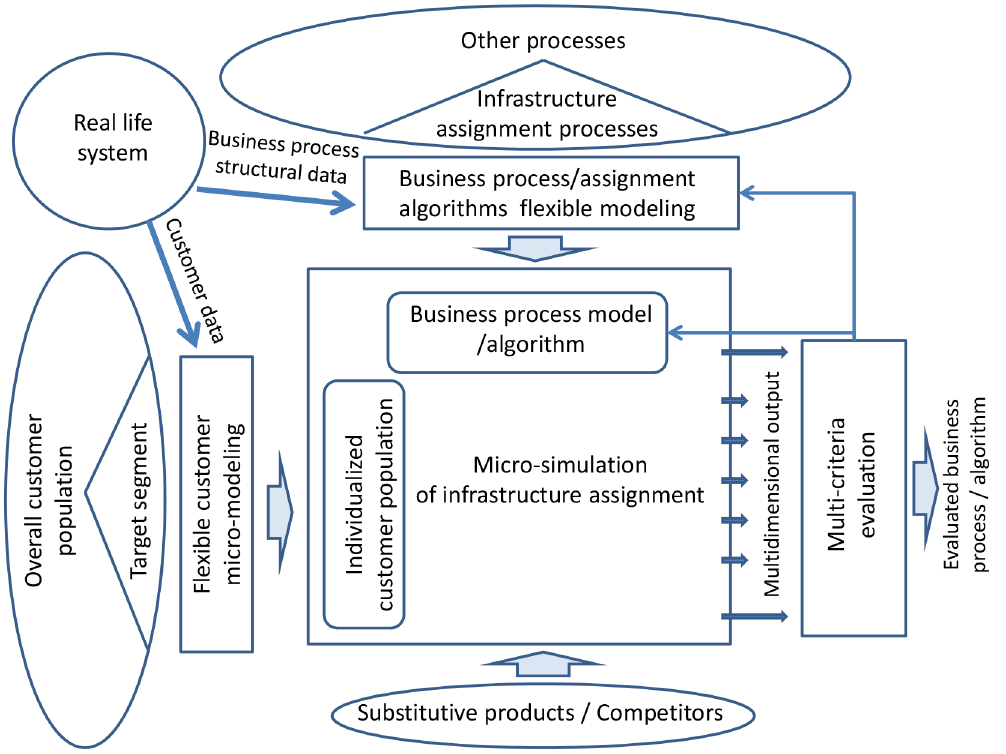
Figure 1. Structure of the proposed integrated